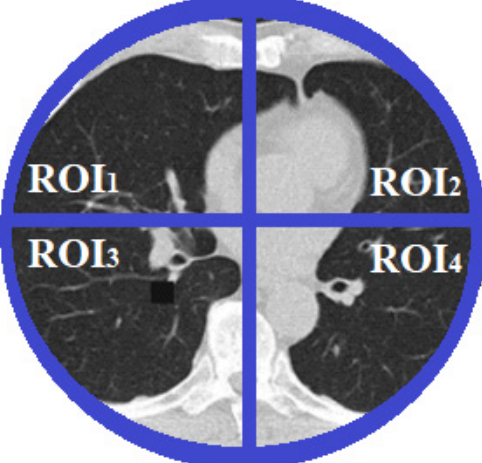
Fig. 1. Lungs Classification to four regions.